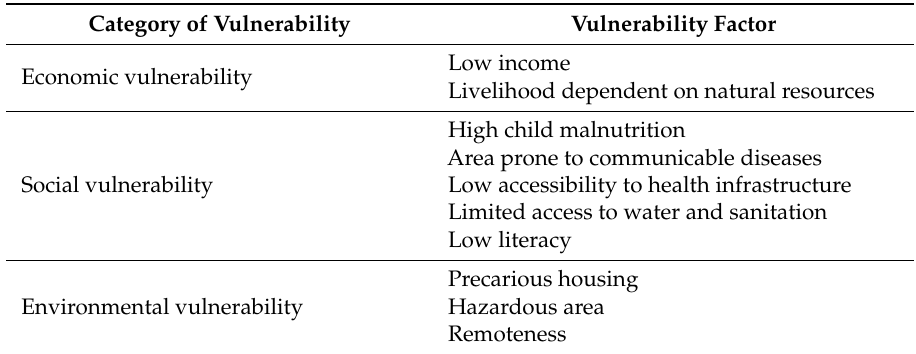
Table 1. Household vulnerability factors in Madagascar. Category of